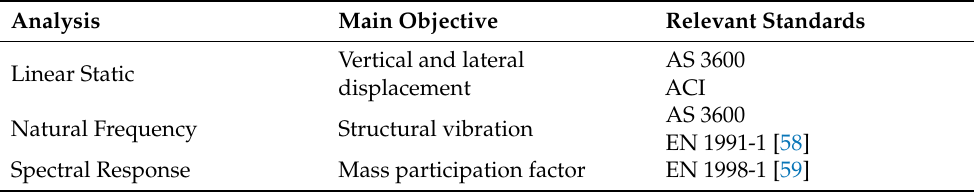
Table 11. Validation of the analyses, in accordance with the available standards.